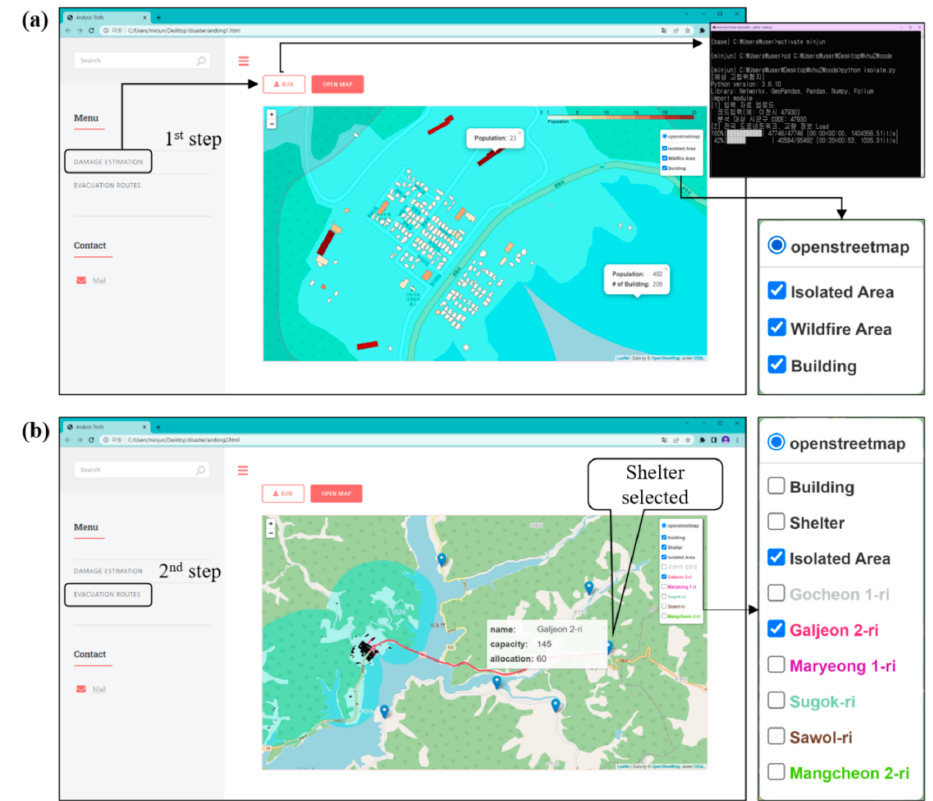
Figure 10. Web-enabled GIS application: ( a ) first function: damage estimation; ( b ) second function: evacuation route